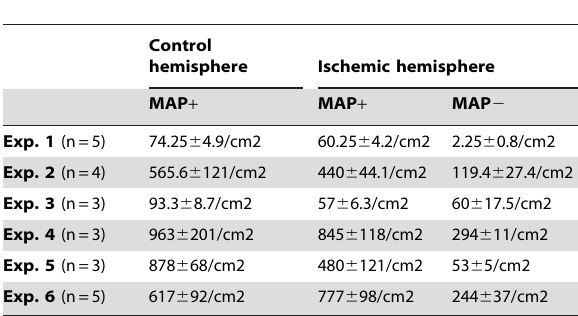
On the left, the number of slices on which counts were made for each experiments is